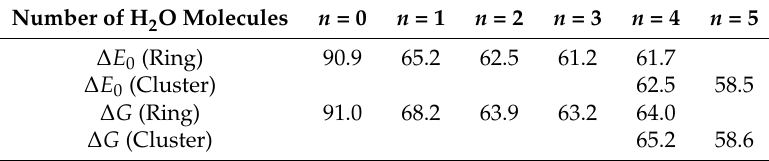
Figure 7. The energy barrier for the oxidation of a CH OH in water with and without the catalyst 3 of H O molecules when a CH OH and H O molecules form a ring structure. The energy barrier is 2 3 2 calculated from the difference of the electronic energies corrected by the zero point energy between a transition state and a reactant compound. Table 1. The energy barriers (kcal/mol) as well as the free energy differences (kcal/mol) at 298.15 K between a reactant compound and a transition state for the oxidation of a CH OH in water without and 3 with the catalyst of H O molecules. We consider the oxidation processes catalyzed by H O molecules 2 2 in the following two arrangements: (1) a CH OH and H O molecules form a ring structure, and (2) a 3 2 CH OH is bonded to a cluster of H O molecules by hydrogen 3 2